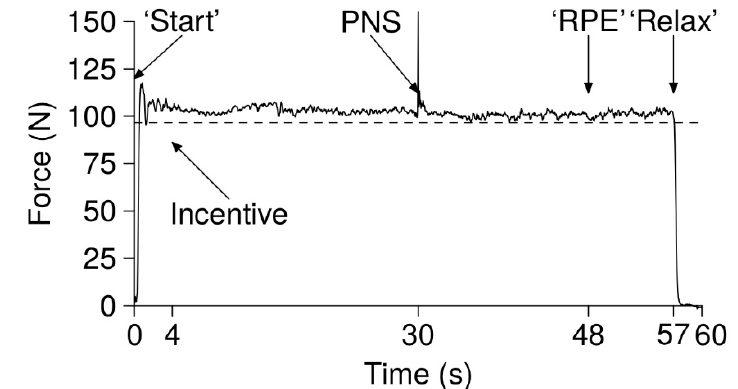
Figure 2. The knee extension task. The task consisted of keeping a cursor over a threshold line (dashed line on the present figure, corresponding to 15% maximal voluntary contraction(MVC)) displayed on a screen in front of the participant, until self-disengagement, by means of an isometric knee extension. If, at one time point, the cursor stayed below the line for more than 2 s, the task was terminated. Participants were told that they could stop the task at any time they wanted. The task was displayed on the screen in 1 min long frames. At the beginning of the frame, an investigator indicated that the participant could initiate the contraction by saying “start”. At 4 s, the investigator told the participant how much money he had already earned and how much money he would earn if he completes the 1 min frame. At 30 s, a peripheral nerve stimulation (PNS) of the femoral nerve was triggered to elicit a maximal M-wave. At 48 s, participants were asked to give their rate of perceived exertion. At 57 s, the participant was told to fully relax their knee extensor muscles.